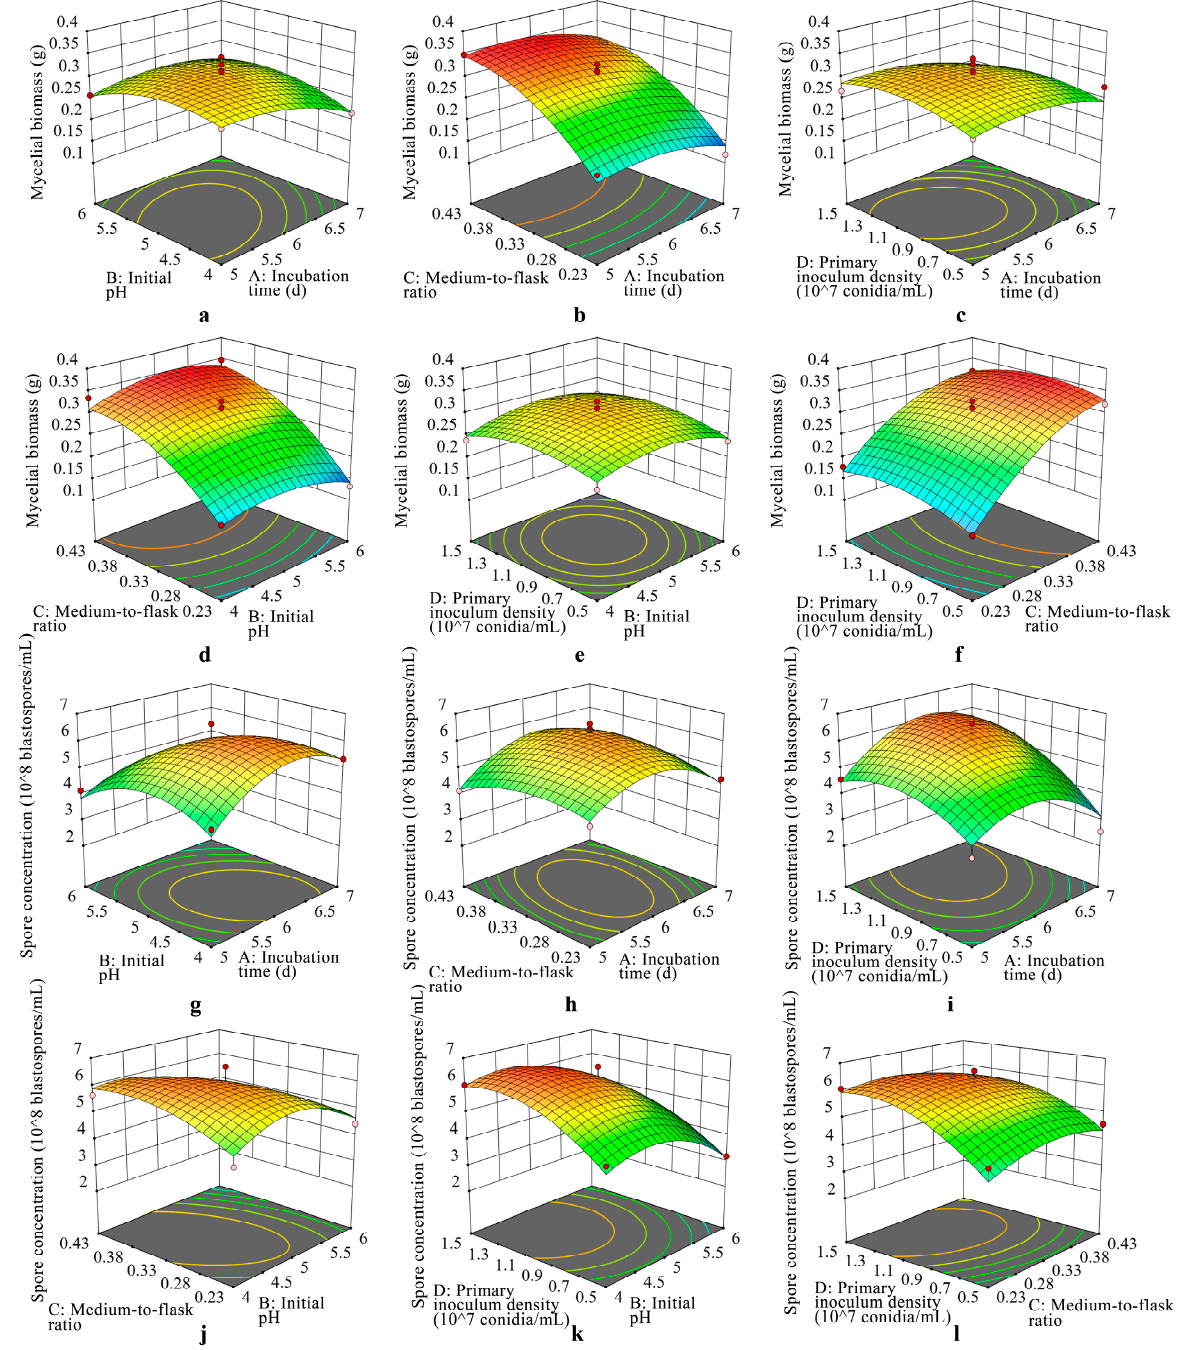
Figure 5. Response surface plots of the mycelial biomass and spore concentration of strain JMF-01. In the figure, ( a – f ) are the response surface diagrams of each factor on the mycelial biomass of strain JMF-01; and ( g – l ) are the effects on spore concentration.